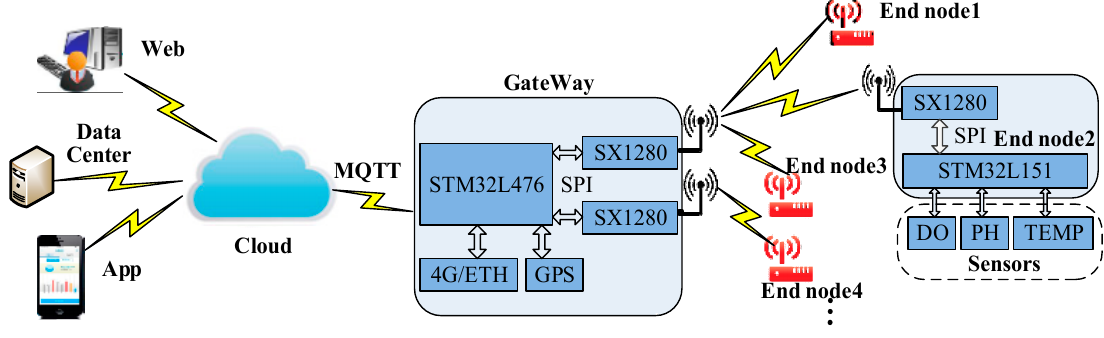
Figure 7. Network Figure 7. Network architecture. Figure 7. Network architecture.